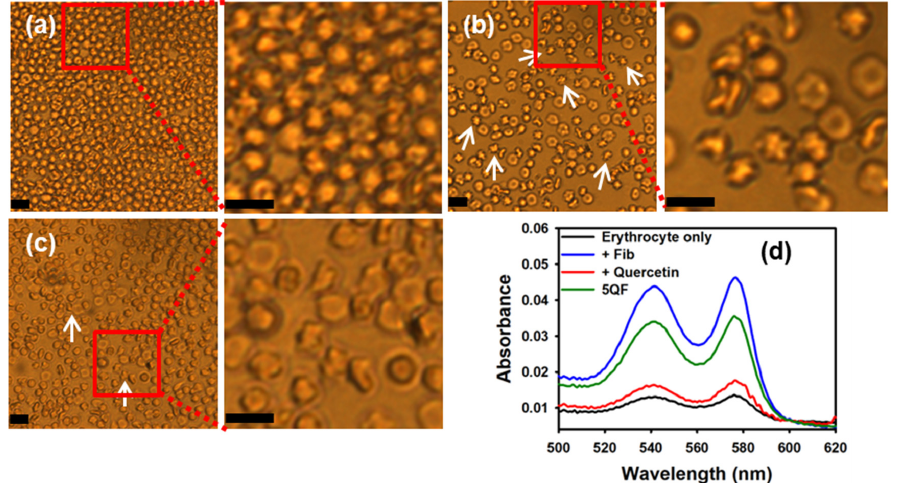
Figure 4. Hemolytic assays of mouse erythrocytes ( a ) without treatment, ( b ) treated with Fib, ( c ) treated with 5QF. In each sample, part of the field is enlarged for clarity. Part of the shrunken cells are shown by arrows in ( b , c ). The scale bar represents 10 µ m. ( d ) The quantitative comparison of oxy-hemoglobin escaped from erythrocytes monitored by absorption spectroscopy.